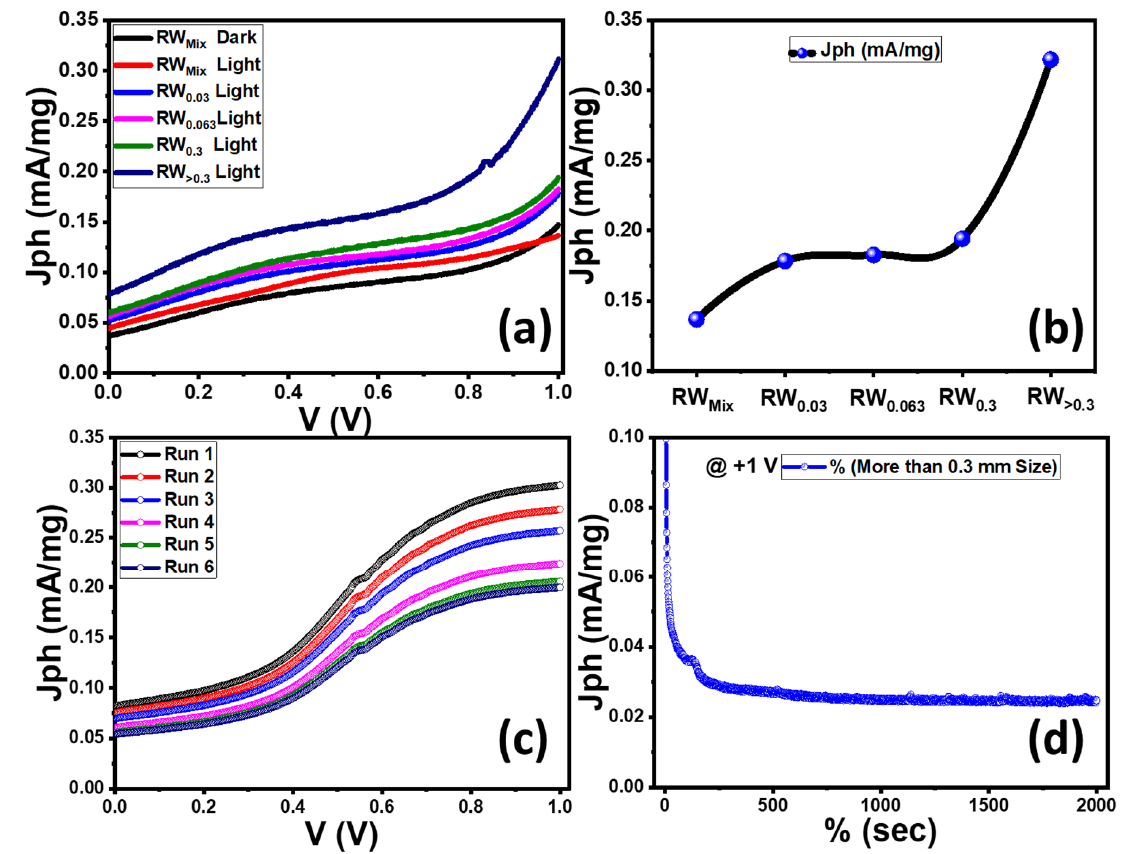
Figure 7. ( a ) Photocurrent density versus the applied voltage (J ph –V) for all RW samples; ( b ) variation of J ph @1 V for RW samples of different sizes; ( c ) reproducible study of J ph –V curves for RW >0.3 ; and ( d ) J ph –Time Stability for RW >0.3 .